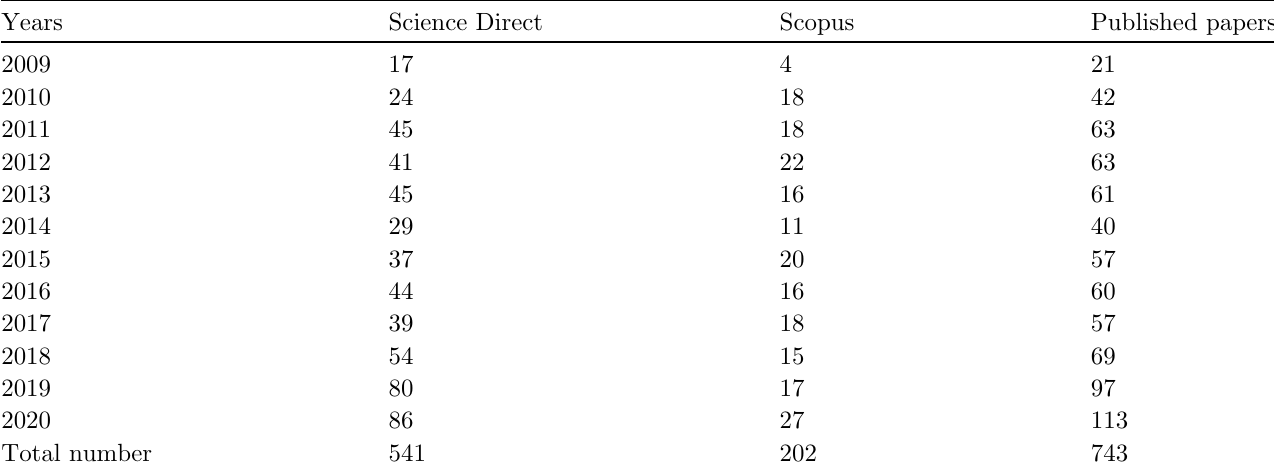
Table 2. Biohydrogen production via photo-fermentation ’ bibliographic